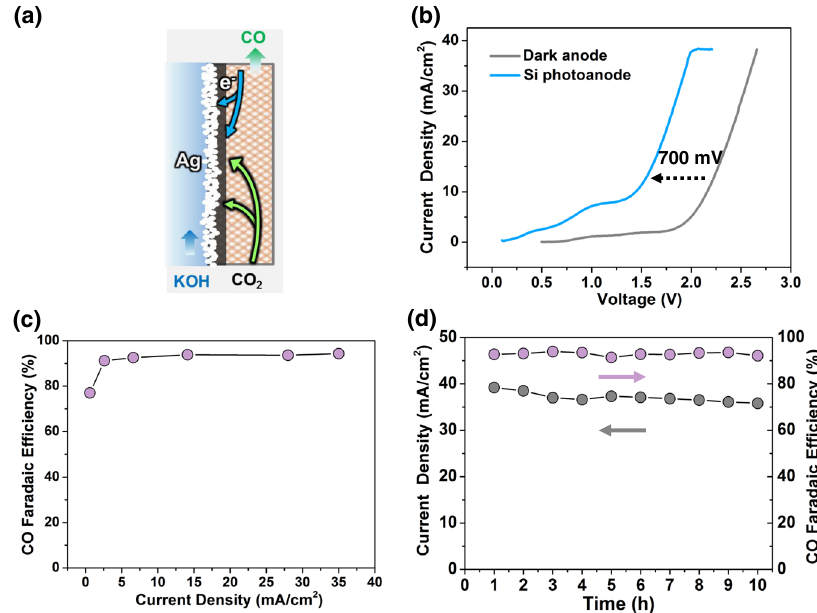
Fig. 3 | Performance of CO 2 to CO with Si photoanode assistance. a The sche- maticofAgcathode. b The J – V curvesofCO 2 RRwithandwithoutSiphotoanodein a two-electrode con fi guration. c The FE of CO at different current